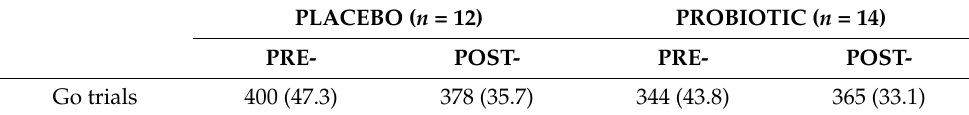
Table 5. The average median of RTs expressed by mean and standard error.